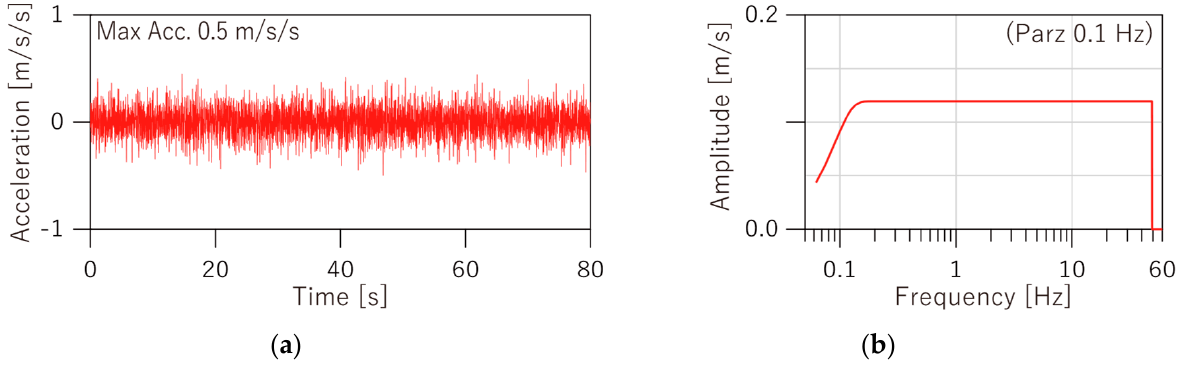
Figure 14. White noise wave used in shake table test: ( a ) Acceleration time histories; ( b ) Fourier amplitude spectrum.